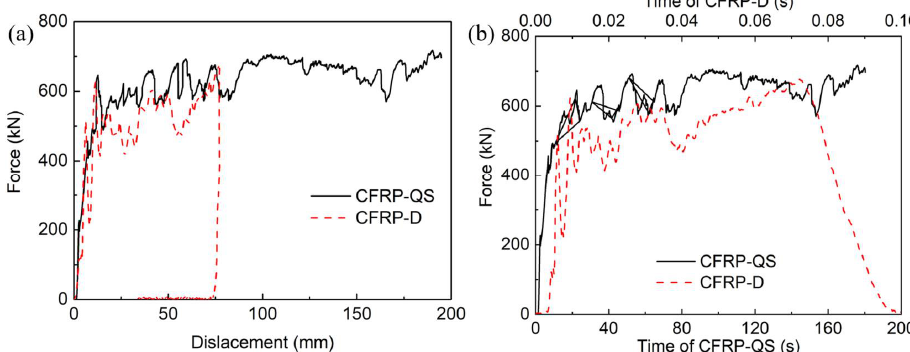
Figure 5. Comparison of axial crushing ( a ) force–displacement curves and ( b ) force–time curves.